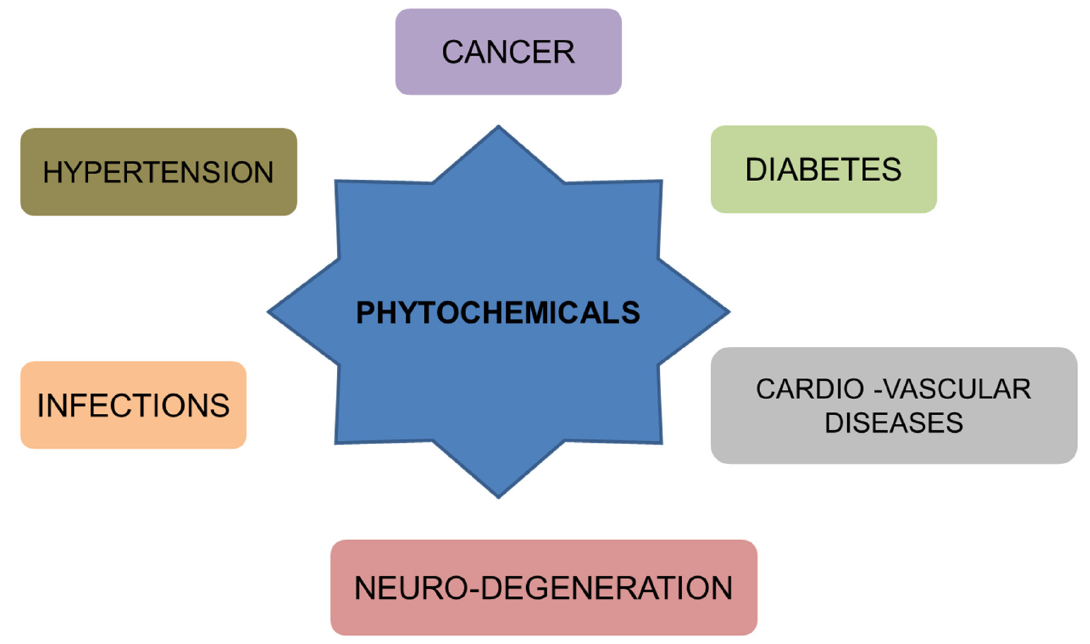
Figure 1. Therapeutic potential of phytochemicals in di ff erent human ailments.